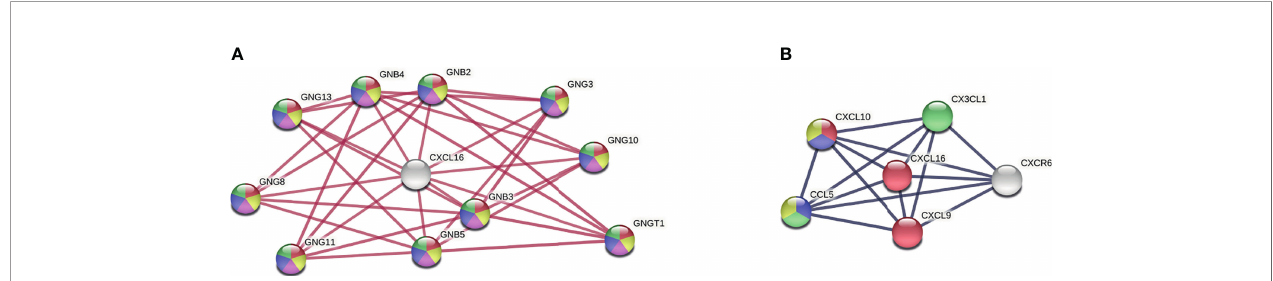
FIGURE 5 | CXCL16 interaction network. (A) Physical network of CXCL16 indicating physical protein associations. Colours present fi ve of the most upregulated KEGG pathways (strength > 2, FDR < 5.94e-21): Red = GABAergic synapse (hsa04727), yellow = serotonergic synapse (hsa04726), purple = cholinergic synapse (hsa04725), blue = glutamatergic synapse (hsa04724), green = dopaminergic synapse (hsa04728) (B) Full network of CXCL16 indicating functional and physical protein associations. Colours present four of the most upregulated biological processes from gene ontology (strength > 2, FDR < 0.00021): Red = T cell chemotaxis (GO:0010818), blue = regulation of T cell chemotaxis (GO:0010819), green = macrophage chemotaxis (GO:0048246), yellow = positive regulation of monocyte chemotaxis (GO:0090026). Networks were generated by using the STRING version 11.0. GNB, beta unit of guanine nucleotide-binding proteins; GNG, gamma unit of guanine nucleotide-binding